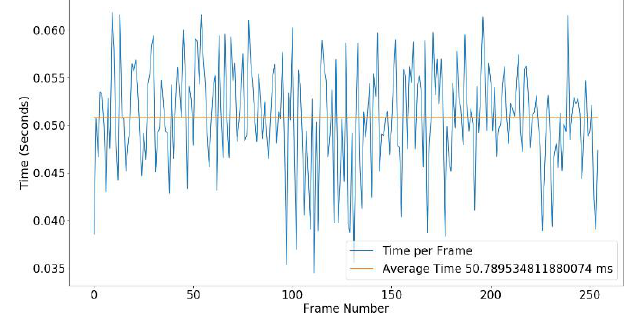
Fig. 13. Processing time per frame